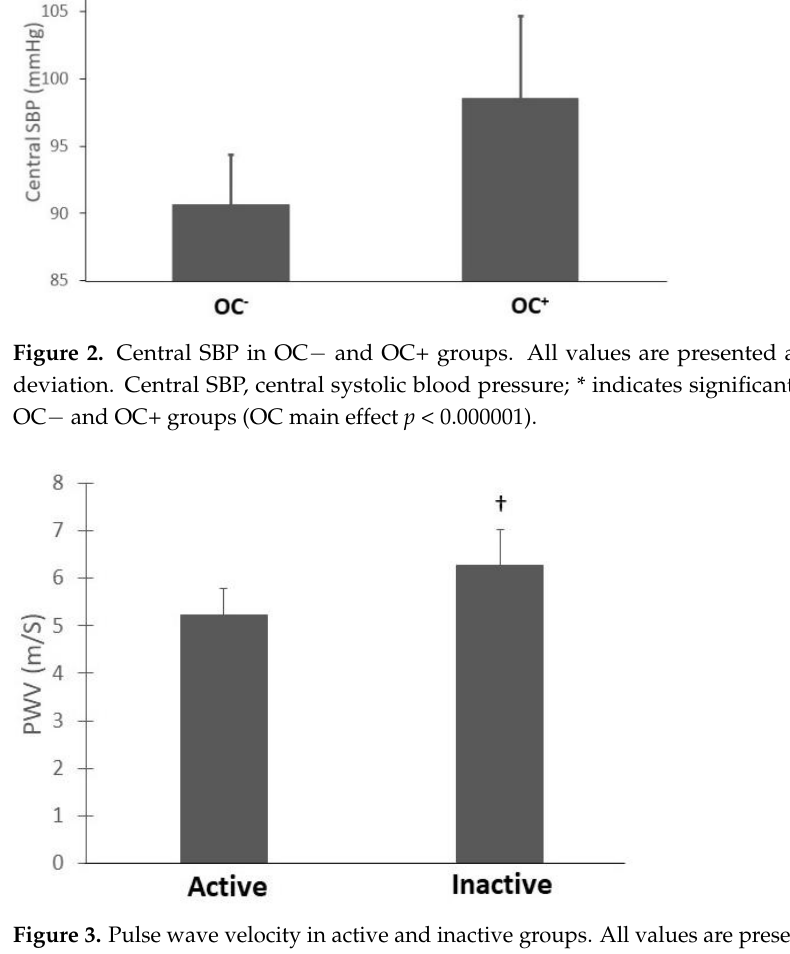
Figure 3. Pulse wave velocity in active and inactive groups. All values are presented as mean ± standard deviation. PWV, pulse wave velocity; † indicates significant difference between active- and inactive groups (physical activity main effect p < 0.0001).